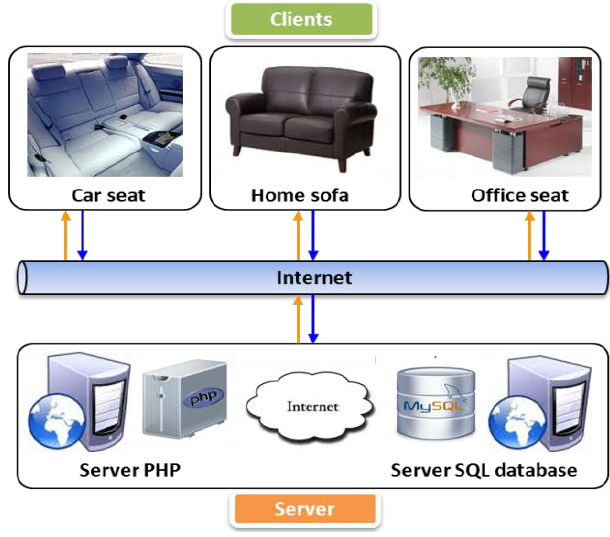
Figure 8. Health monitoring cloud computing architecture where health data from multiple locations are monitored via a cloud